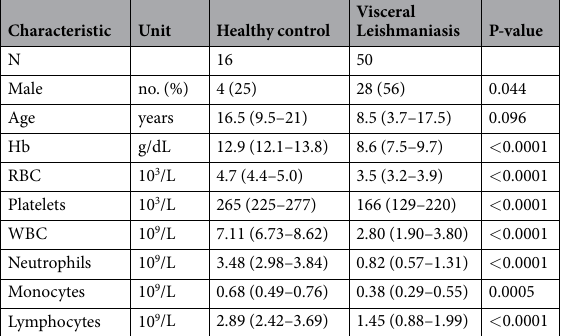
Table 1. Baseline characteristics of the study participants. Values represent median and interquartile ranges, except for gender distribution, which is shown as percentage. Data were analyzed using the Mann-Whitney U test (continuous variables) and the Fisher’s exact test (frequency analysis). Abbreviations: Hb, hemoglobin; RBC, red blood cell count; WBC, white blood cell count.